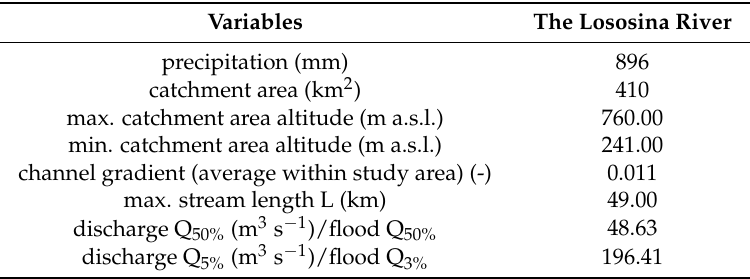
Table 2. Physical characteristics of investigated sites—the Lososina River.